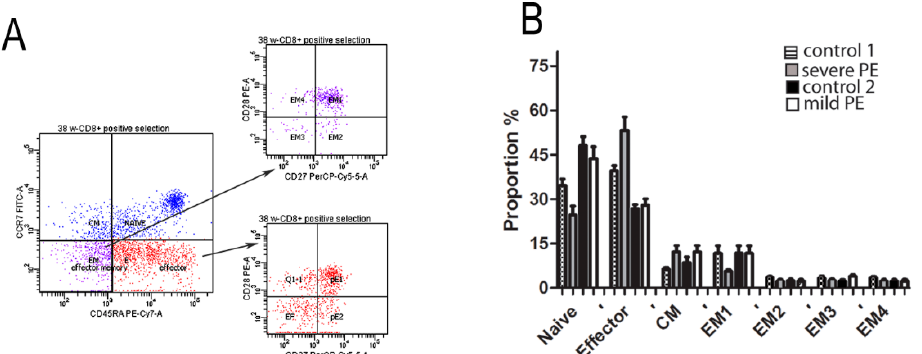
Figure 4. ( A ) Differential expression of CD45RA, CCR7, CD27, and CD28 cell surface markers on total CD8 + T cells from maternal peripheral blood control. CD3 + CD8 + gated cells were separated into four subsets (naive, CM, EM, and effector) based on CD45RA and CCR7 labelling. Blue color presents naïve and CM CD8 + T cells. Effector (red) and EM (purple) were analyzed for CD27 and CD28 co-expression, and the proportion of effector (eP1 and eP2) and EM (EM1, EM2, EM3, and EM4) cells were determined. ( B ) The proportion of CD8 naïve, CM, effector, and EM (EM1, EM2, EM3, and EM4) cells is determined in mPBL from control 1 ( n = 10), severe PE ( n = 10), control 2 ( n = 10), and mild PE ( n = 10).